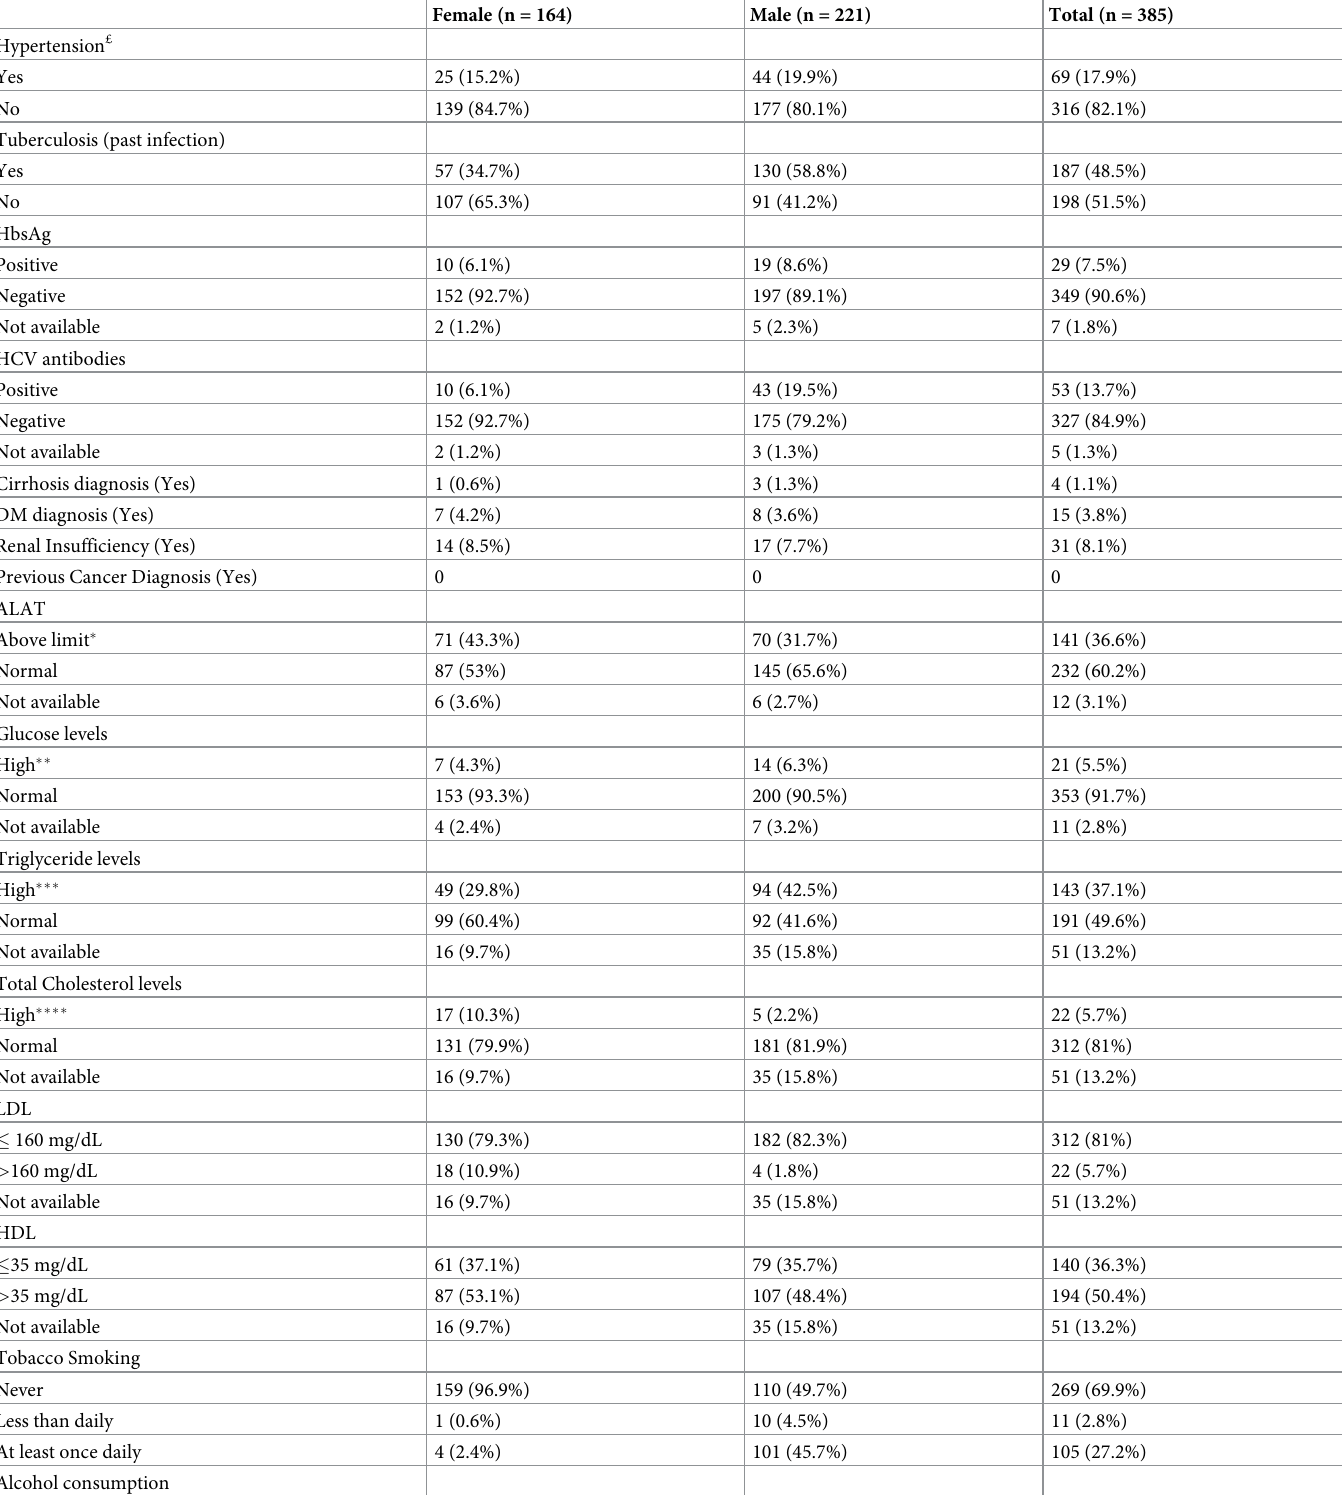
Table 4. Co-morbidities and risk factors among patients participated in the survey according to gender, Dawei,